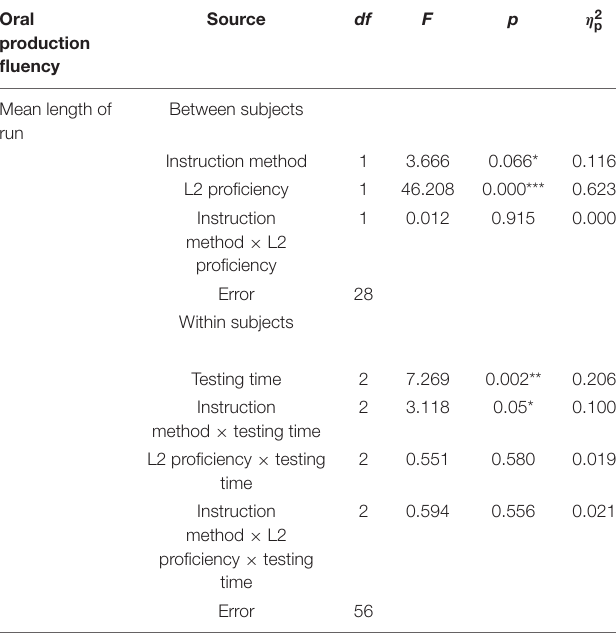
TABLE 7 | Results of three-factor mixed ANOVA for oral production fluency.